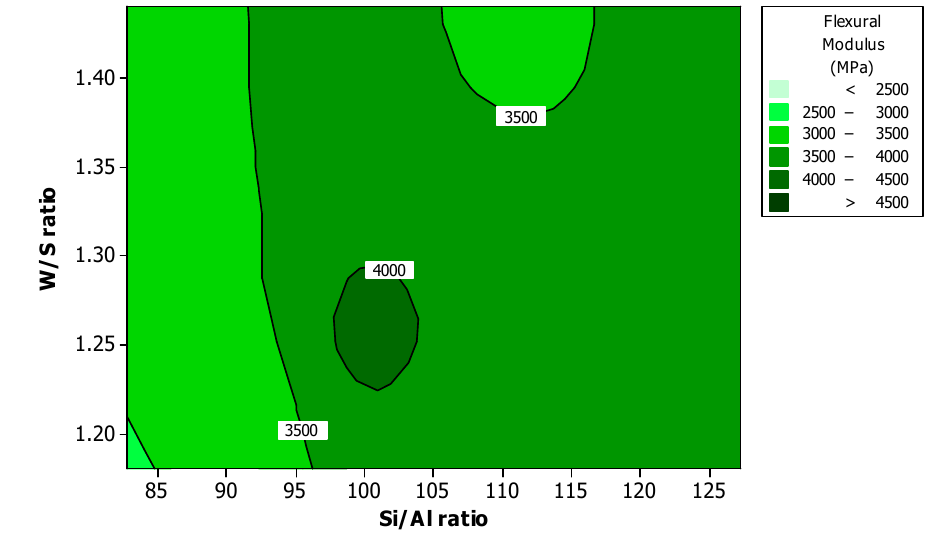
Figure 8. Contour plot of W/S ratio vs. Si/Al ratio for flexural modulus.